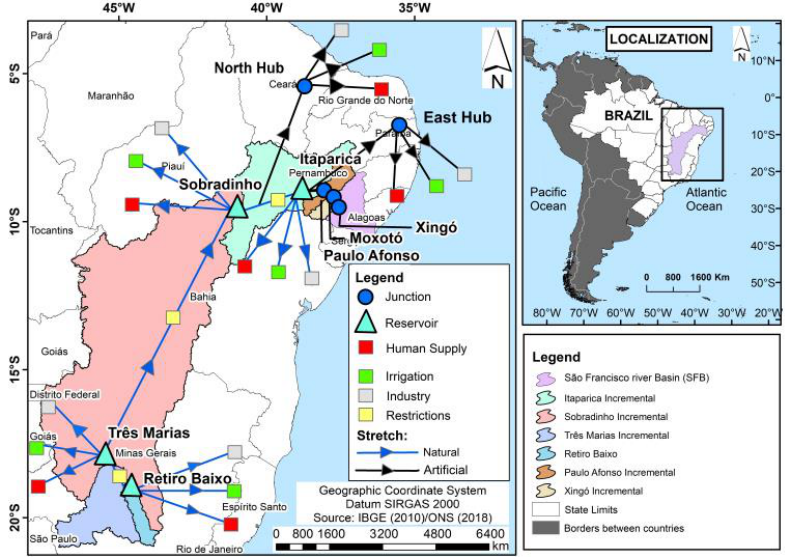
Figure 3. Illustration of the network used for water system operation in SIGA ® .